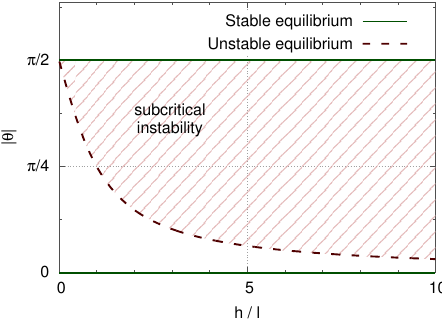
Figure 4. Potential energy (normalized) for a box on a plane with height h = 4 l . Inset: cartoon of the setup where the box is tilted by an angle θ .